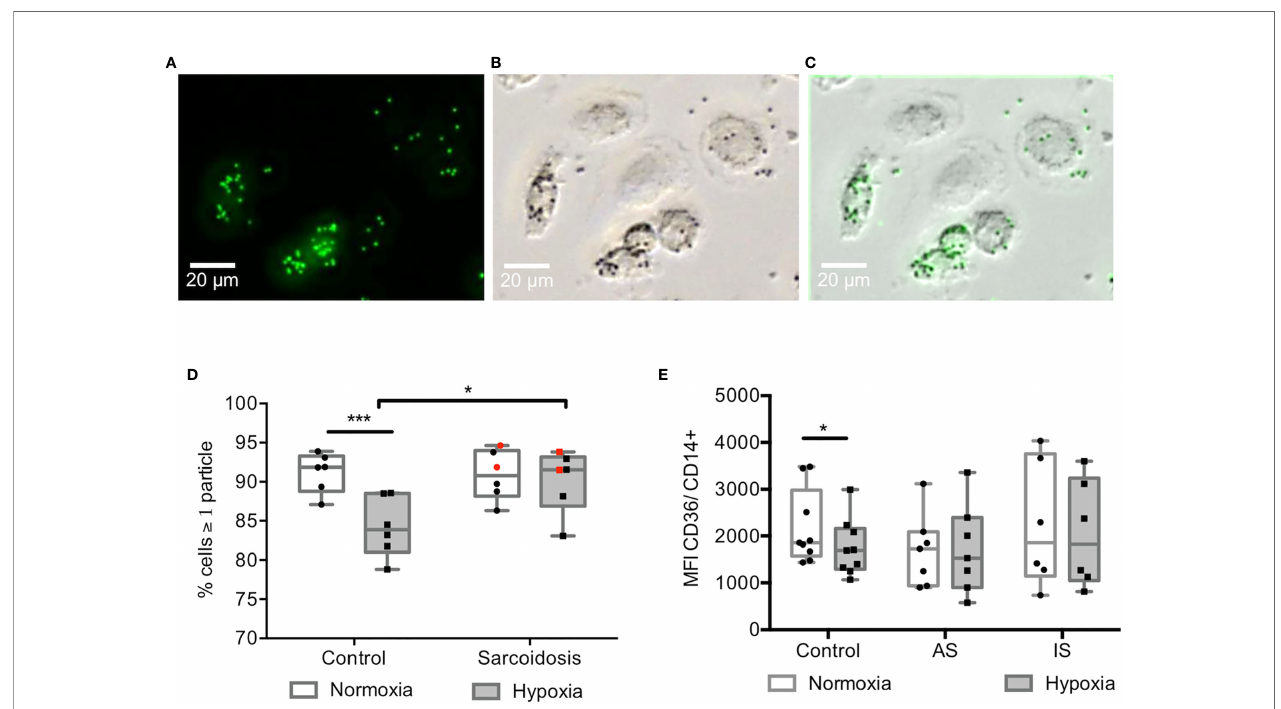
FIGURE 2 | Hypoxia impaired phagocytosis in controls but not in sarcoidosis MD-macrophages. (A – C) Representative image of MD-macrophages exposed to normoxia from high active sarcoidosis after 30 min incubation with fl uospheres (1µm) followed by four PBS washes (magni fi cation x 200); (A) fl uorescent 1µm fl uospheres (green) (B) , phase-contrast images of MD-macrophages (C) , overlay images showing fl uospheres within MD-macrophages. (D) Effect of hypoxia on phagocytosis in controls and sarcoidosis patients estimated by the ratio of cells with at least one particle and the total number of cells. Each point indicates a patient and/or control (n=6/group). In sarcoidosis group, black dots represent high active sarcoidosis (AS), and red dots low active or inactive sarcoidosis (IS); (E) Effect of hypoxia on the CD36 scavenger receptor expression in controls, AS, IS; analyzed by fl ow cytometry of CD14+ MD-macrophages. The results are expressed as the mean CD36 fl uorescence intensity (MFI). Each point indicates a patient and/or control (n= 6-9/group). Results are expressed as box plot showing 25 th and 75 th percentile and median *p < 0.05; ***p < 0.001 in two-way ANOVA-repeated measures with Sidak post-hoc